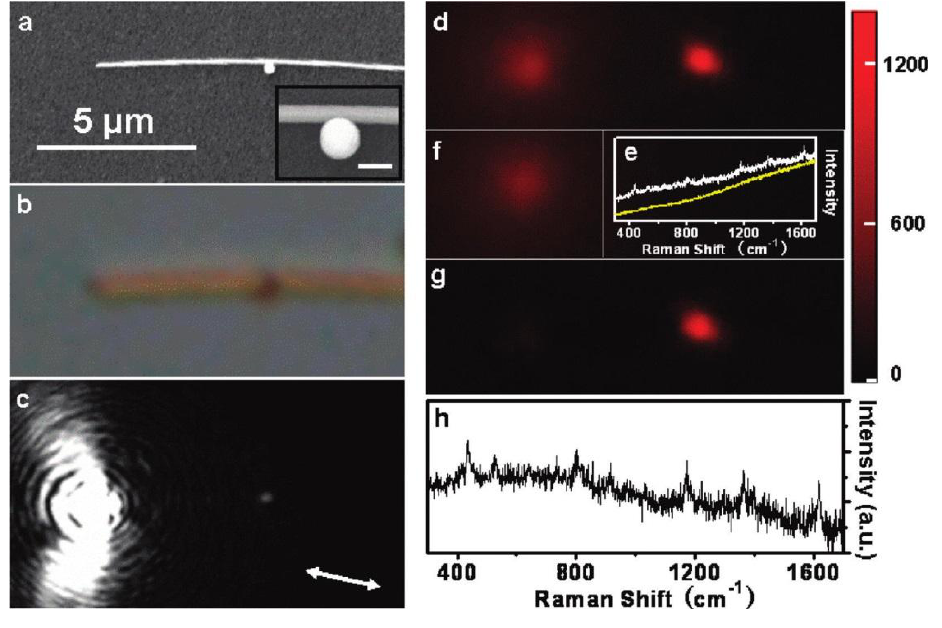
Figure 1. Remote SERS of MGITC excited at the particle/nanowire junction. ( a , b ) Scanning electron microscope (SEM) and optical images of the structure, respectively; ( c ) Optical image of SPP propagation excited by 633 nm laser; ( d ) Raman image at 436 cm −1 ; ( e ) Spectra measured at the nanojunction (white) and the excitation spot (yellow); ( f ) Background fluorescence image of the substrate; ( g , h ) The corresponding Raman image and SERS spectrum after background correction. Adapted with permission from